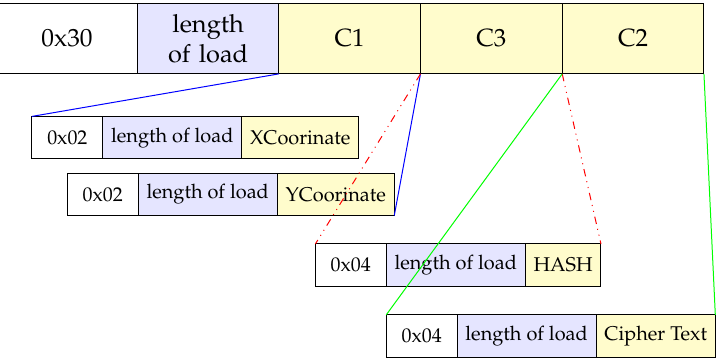
Figure 2. SM2 ciphertext encodes ASN.1.